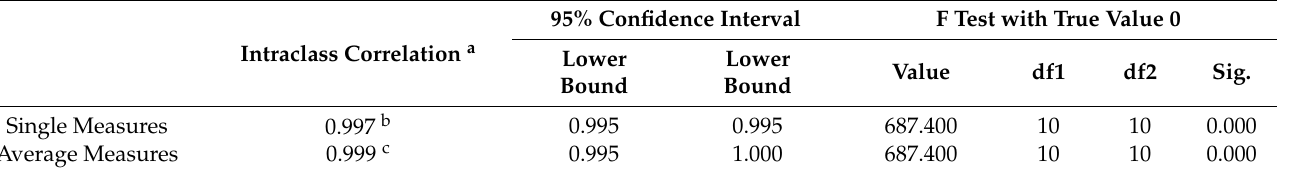
Table 2. Intraclass correlation coefficient. Evaluation of agreement between continuous measurements.